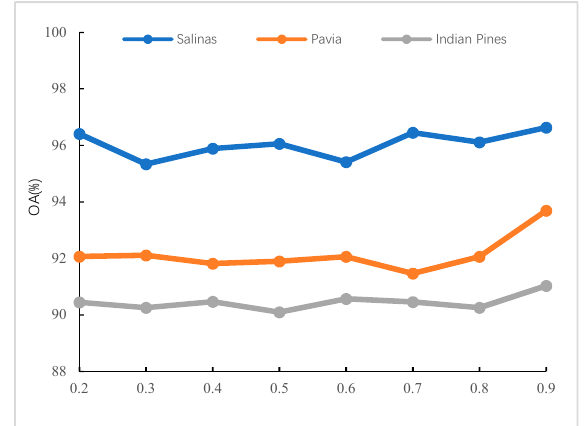
Figure 8. Analysis of the performing results of the parameters 𝜺 .